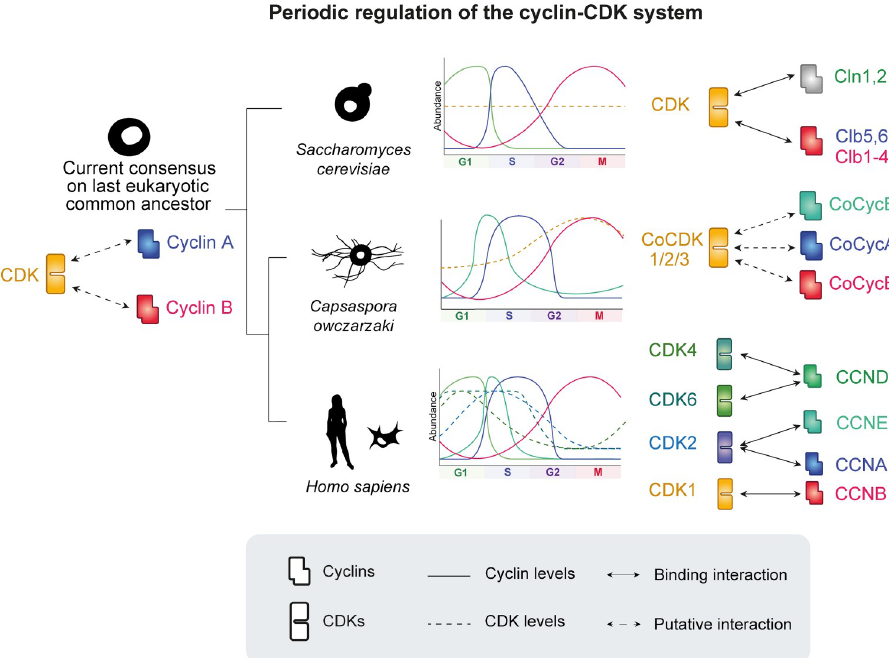
Fig 7. A model of the dynamics of the Cyclin/CDK system in Capsaspora . Bold lines indicate cyclin levels and dashed lines indicate CDK levels across the cell cycle. Independent phylogenetic studies suggest that a diversified set of cell cycle cyclins A and B existed prior to the last common ancestor of eukaryotes (LECA). Some of these components were secondarily lost and independently expanded in different eukaryotic lineages, such as in fungi (which includes S . cerevisiae ). Based on our phylogenetic and transcriptomic analysis, a likely scenario is that several cell cycle cyclins may be binding to a single CDK that is not transcriptionally stable in Capsaspora . This suggests the expansions of cell cycle cyclins predate the expansion of cell cycle CDKs, which later acquired specific binding to cell cycle cyclins in